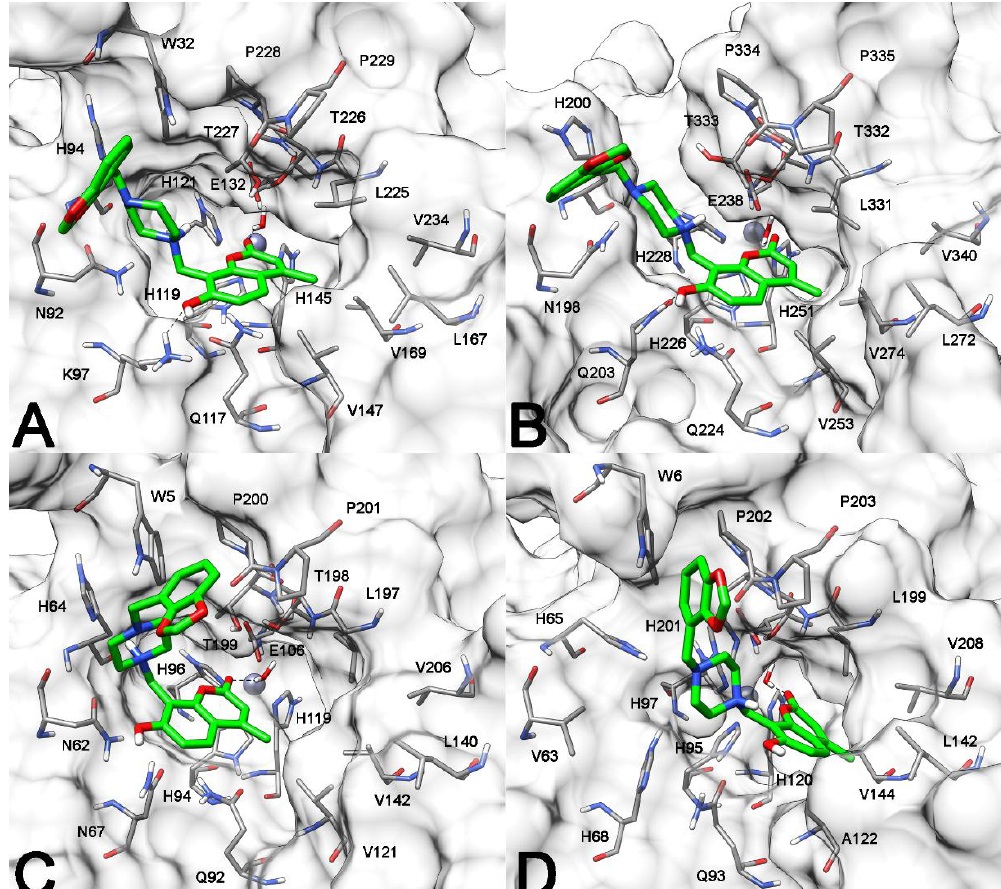
Figure 2. Minimized average structures of compound 13 (green) in complex with h CA XII ( A ); h CA IX ( B ); h CA II ( C ); and h CA I ( D ). Ligand–protein H-bonds are shown as black dashed lines, and the protein surface in the proximity of the ligands is shown in grey. The zinc ion is shown as a gray sphere.